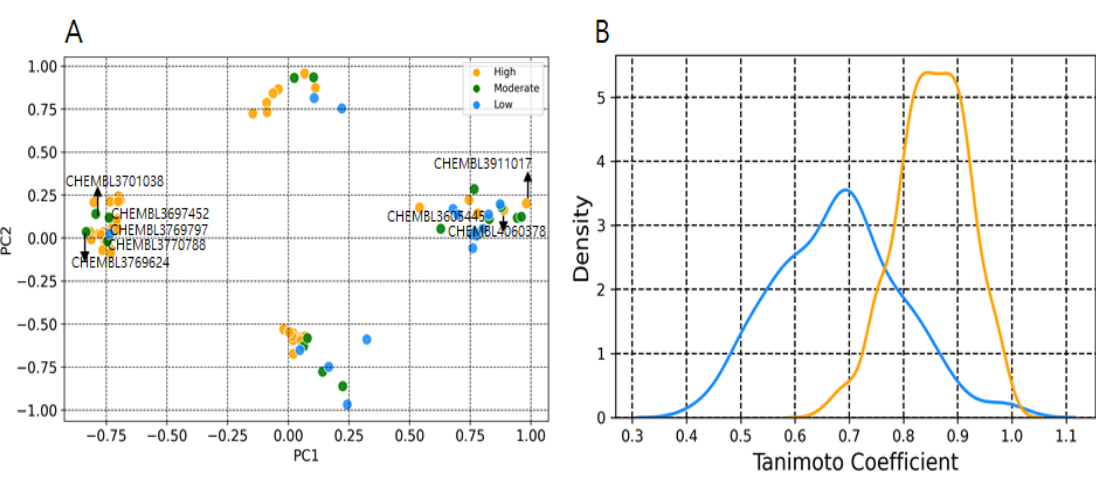
Figure 4. Plot showing the chemical space of falsely predicted compounds and their Tc similarities. ( A ) Distribution of falsely predicted compounds from test set. ( B ) Density plots of Tc values using MACCS fingerprints. Compared were falsely predicted low and moderate vs. high activity compounds (Orange color), and falsely predicted high activity compounds vs. low and moderate activity compounds of training set (Blue color).